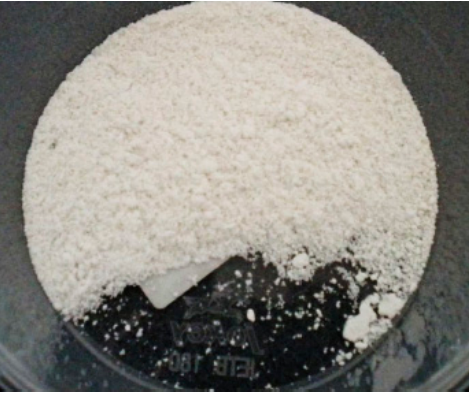
Figure 3. Butyl stearate microcapsules encapsulated in PMMA membranes.